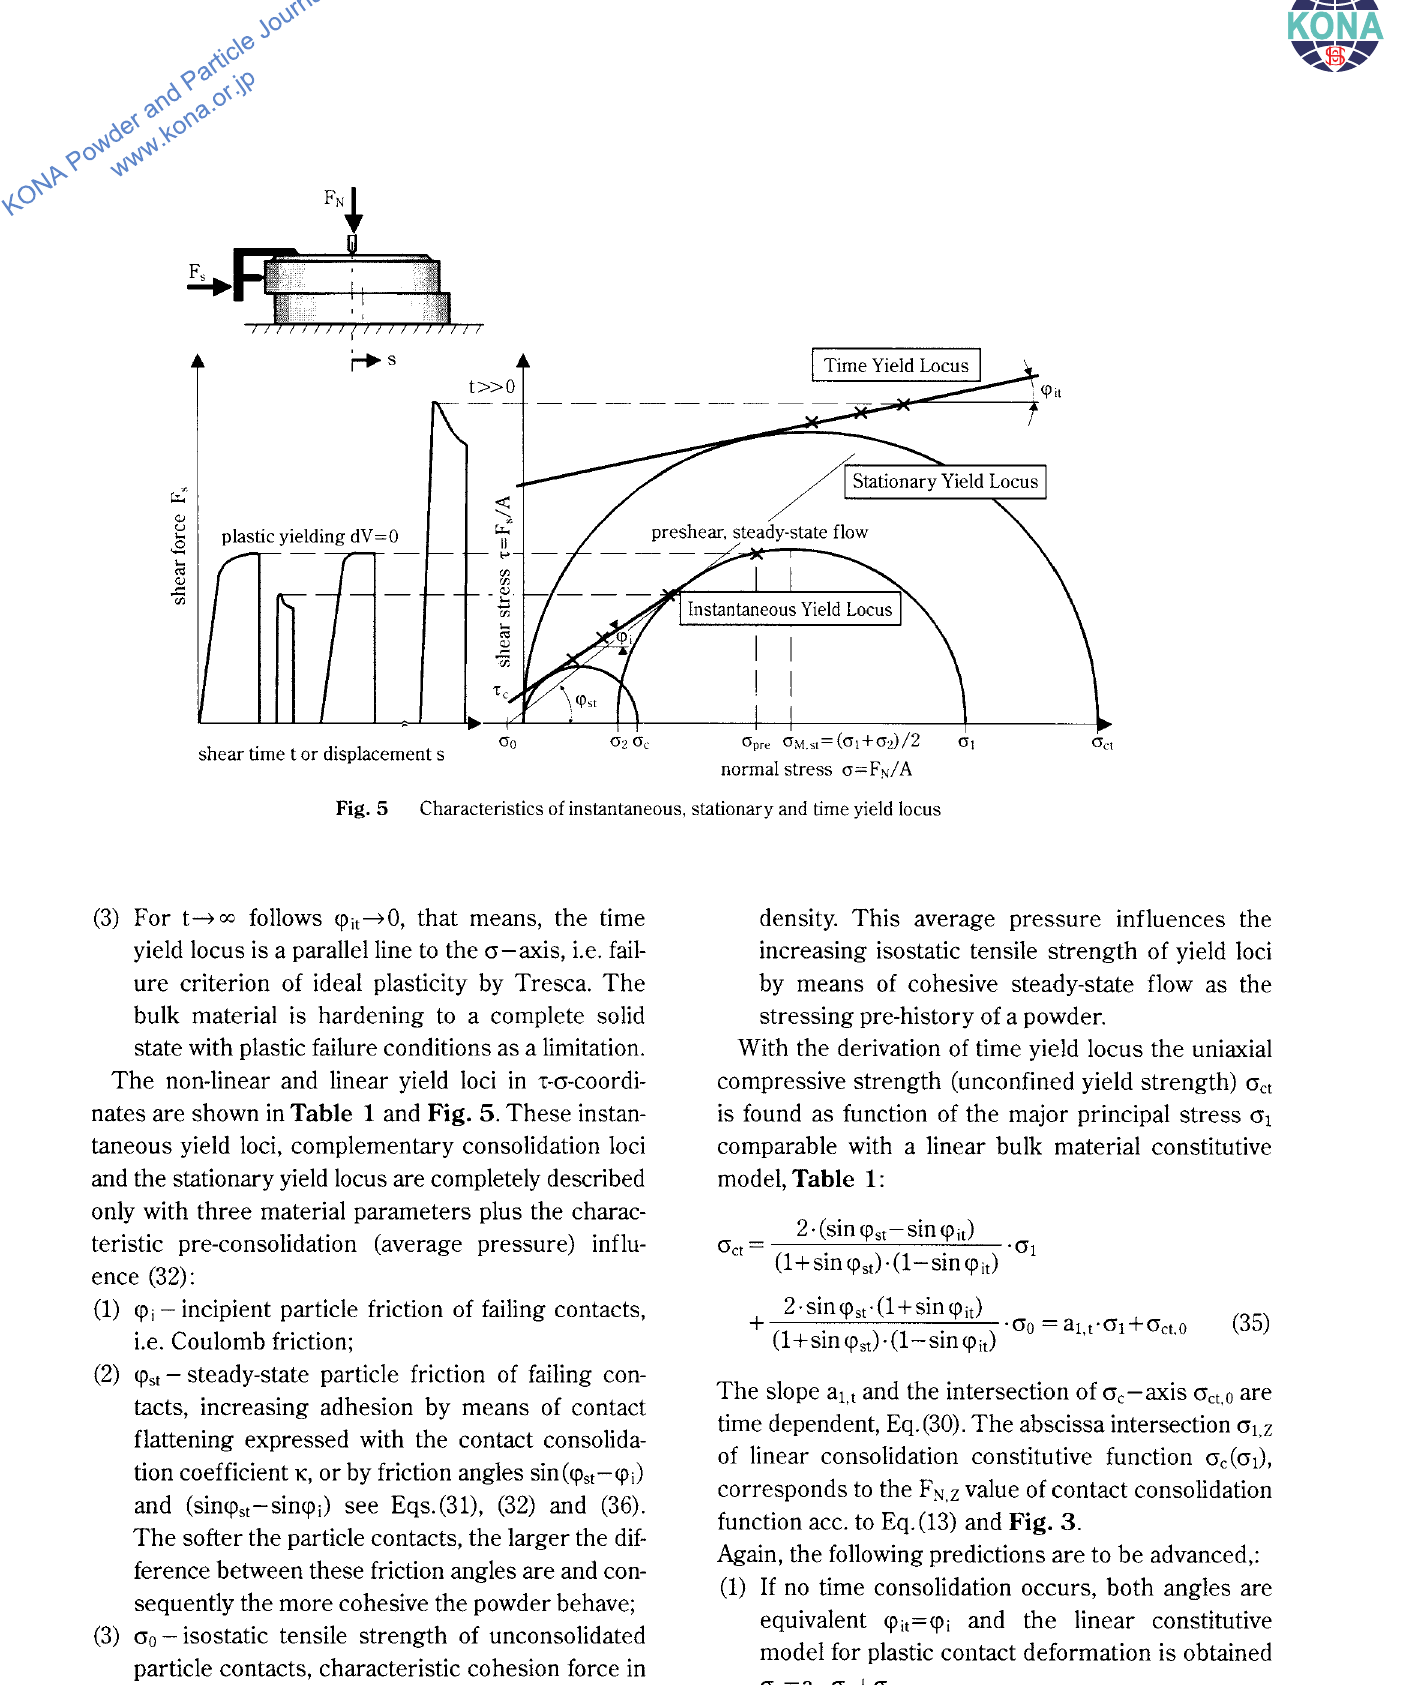
(3) For t~ oo follows <rit~o, that means, the time density. This average pressure influences the